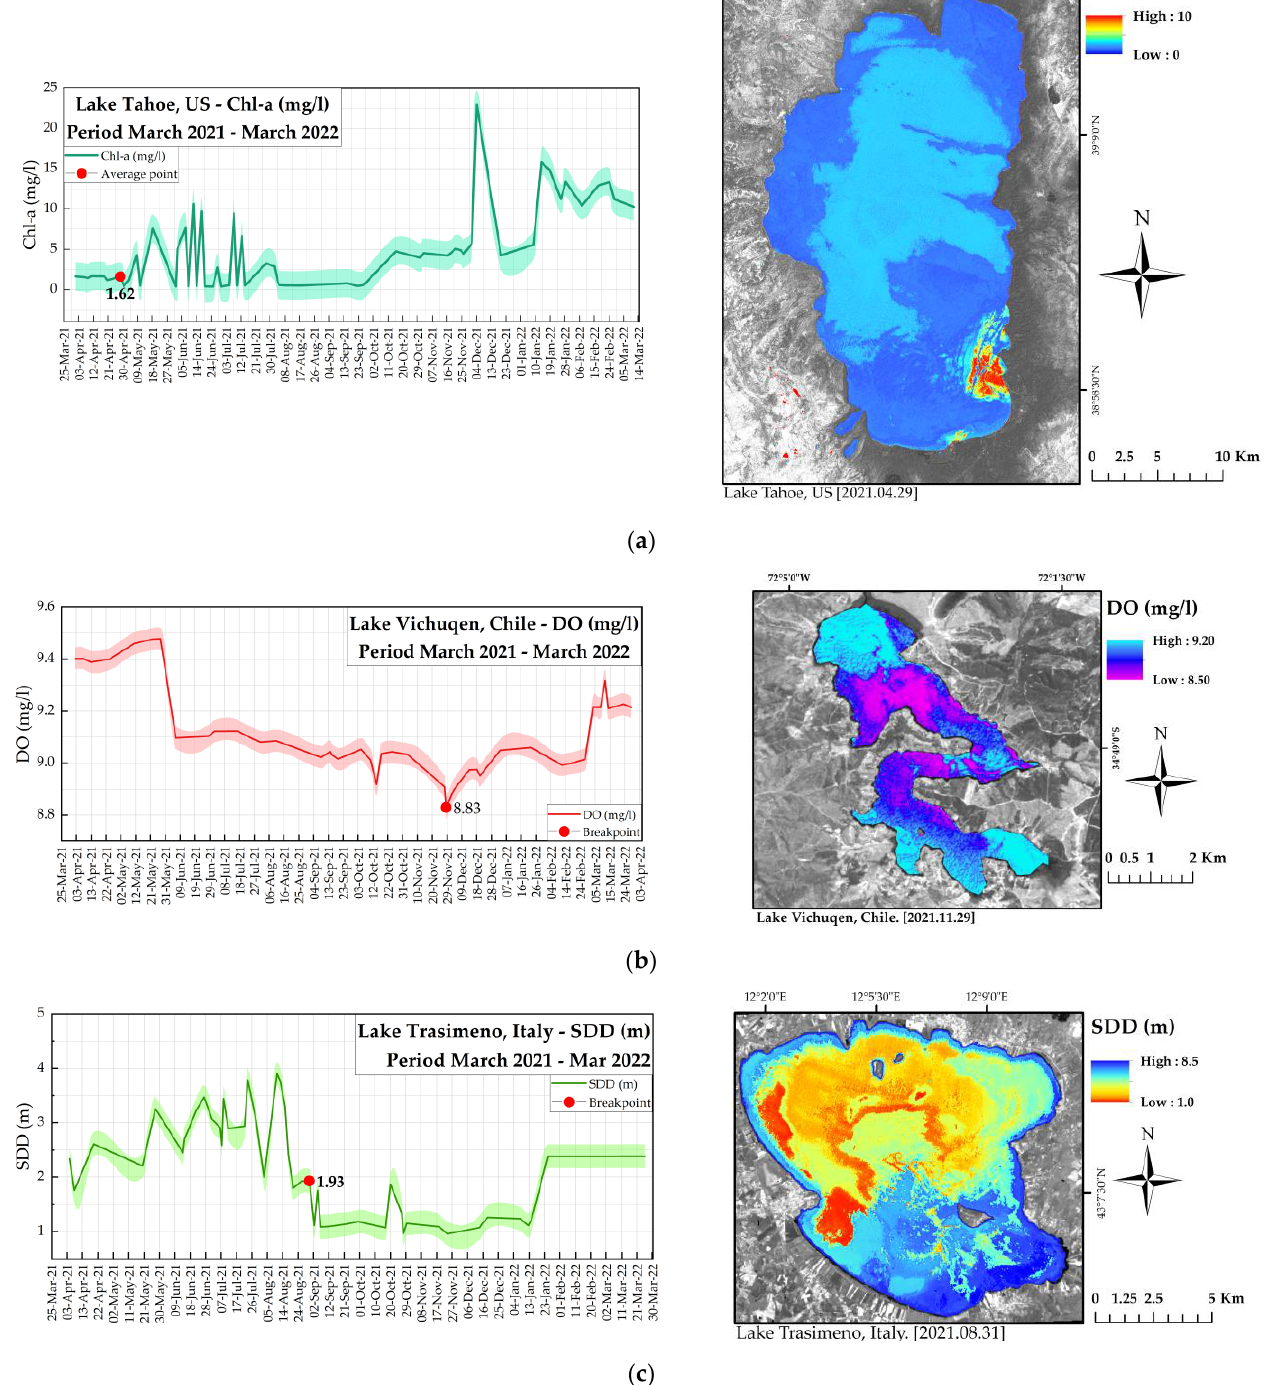
Figure 7. Time series and spatial distribution of ( a ) Chl-a in Lake Tahoe (U.S., 29 November 2021), ( b ) DO in Lake Vichuquen (Chile, 29 November 2021) and ( c ) SDD for Lake Trasimeno (Italy, 31 August 2021). Background image: harmonized red band in greyscale. The plots show the average of the parameter for the whole lake. Spatial variation is visible in the maps.